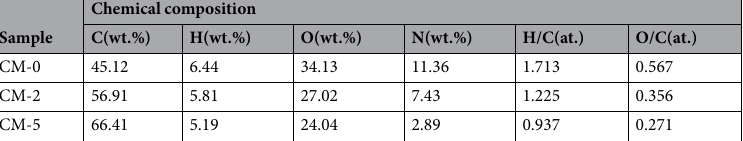
Table 1. Elemental composition of the CM-0, CM-2 and CM-5.